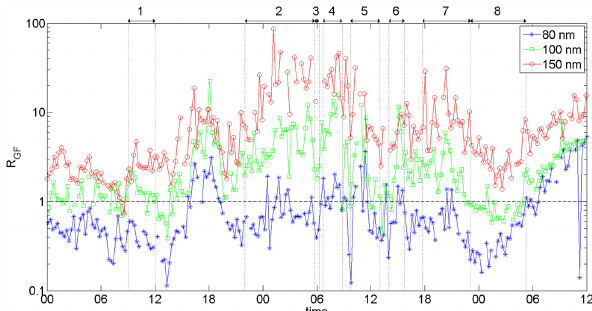
Figure 7. Time series of the ratio between the number con- centrations of more and less hygroscopic particles, R GF = N GF > 1 . 25 /N GF ≤ 1 . 25 , observed during the cloud event on 22–24 October 2011. Different periods described in the text are marked with dashed lines and also with numbered arrows (1, rainy; 2, clean; 3, paper mill; 4, clean 2; 5, heating plant; 6, southern 1; 7, southern 2; and 8, southern